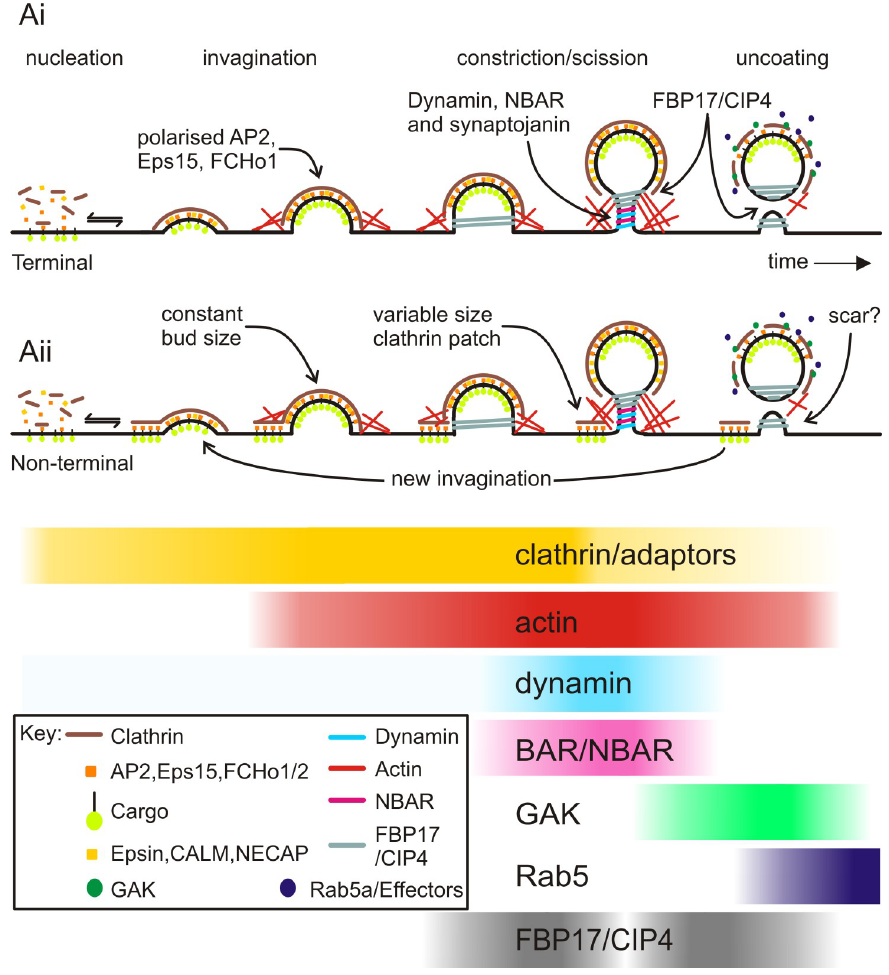
Fig 1. Our view of clathrin-mediated endocytosis before (Ai) and after (Aii) Taylor et al.’s study. Image reproduced under CC-BY 4.0 license, credit: https://doi.org/10.1371/journal.pbio.pbio.1000604.